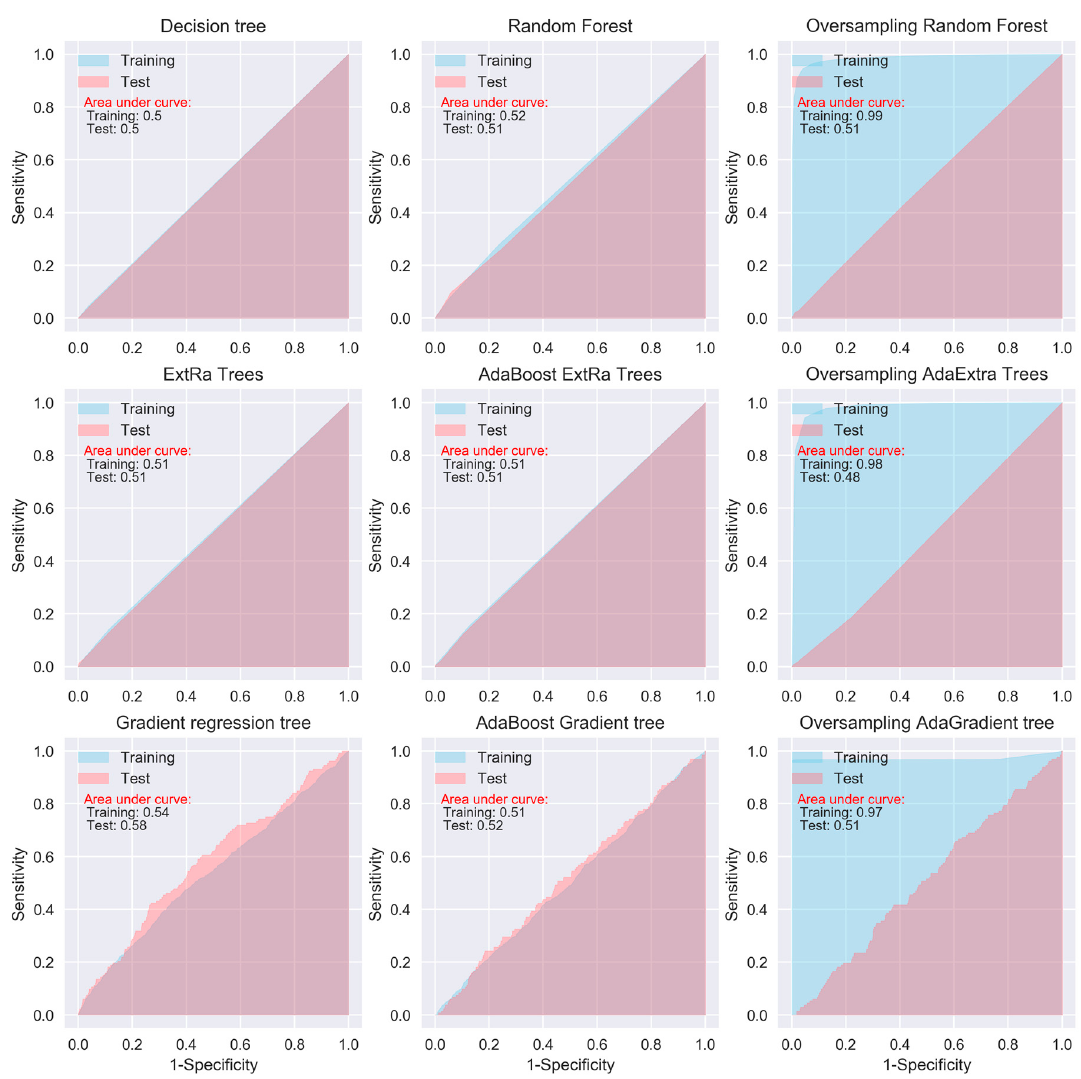
Figure 3. ROC curves of tree-based algorithms.